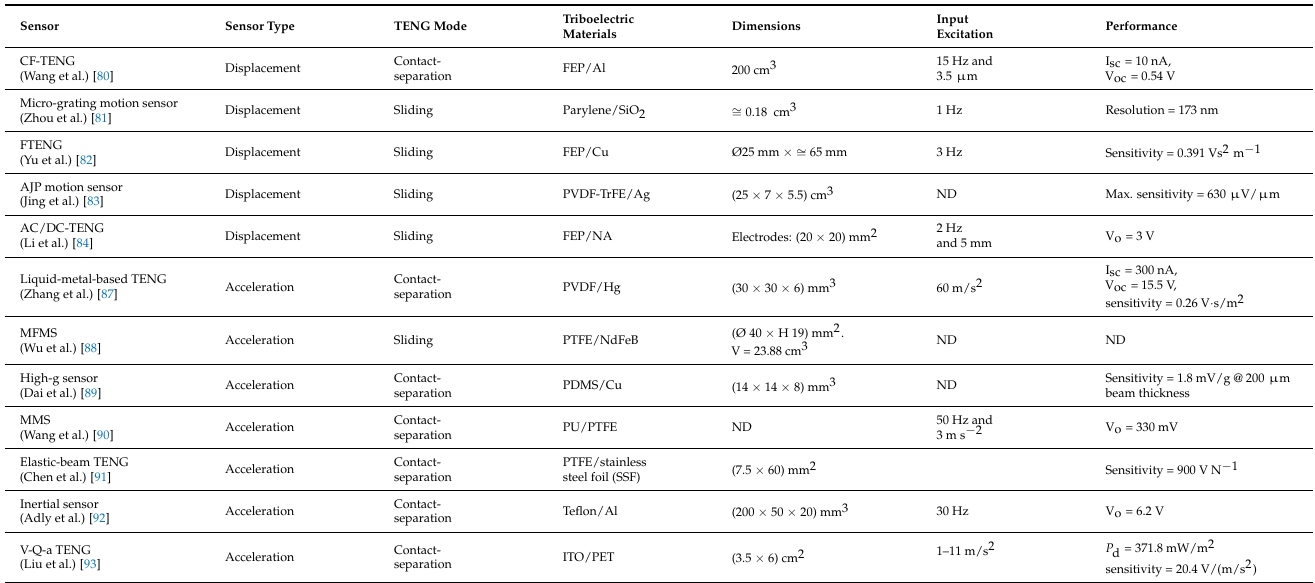
Table 2. Summary of the reviewed TENG vibration sensors, which shows their main features and